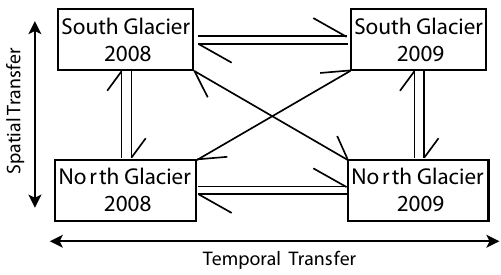
Fig. 2. Diagram of transferability tests. Arrows indicate the possi- ble spatial and temporal transfer of parameter values between data